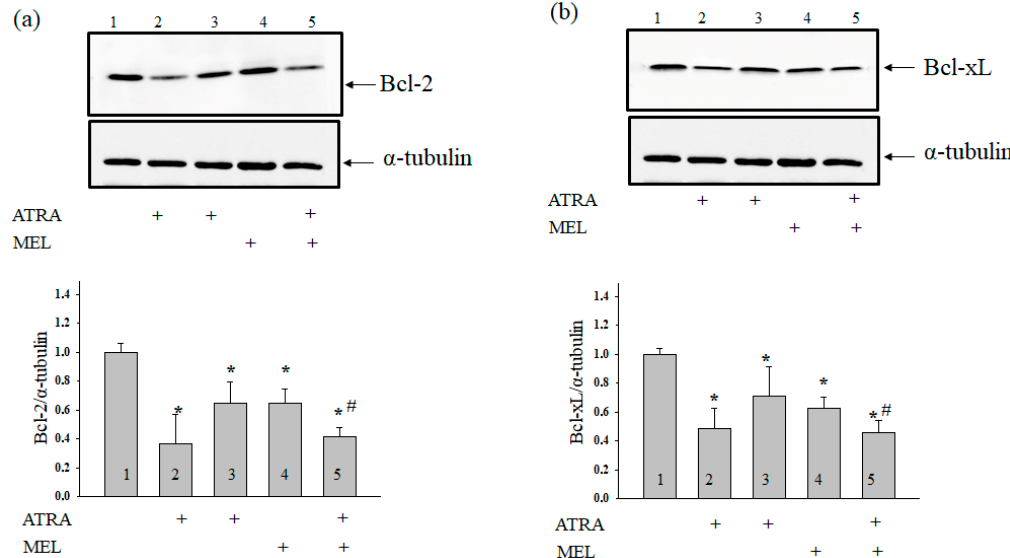
Figure 3. Combined effect of MEL and ATRA on the level of Bcl-2 ( a ) and Bcl-xL ( b ) proteins in HL-60 cells. Cells were seeded in a 96-well plate at a density of 5 × 10 3 cells per well and treated with 1 µ M ATRA (column 2), and 10 nM ATRA (columns 3) and 1 mM MEL (column 4), and MEL in combination with 10 nM ATRA (column 5); untreated cells (control, column 1). Protein samples were extracted and subjected to Western blot for Bcl-2 and Bcl-xL detection. Immunodetection of α -tubulin was used as a loading control. Upper parts-immunostaining of Bcl-2, Bcl-xL and α -tubulin. Lower part-quantitation of immunostaining using computer-assisted densitometry. Bar graphs represent the proteins levels in relative units. The protein level in a cell lysate without any addition was taken to be unity and served as a control. The data are presented as the means ± S.D. of five separate experiments. * p < 0.05 significant difference in the protein level compared with the corresponding control, # p < 0.05 significant difference in the protein level compared to the value that was obtained in the presence of MEL alone.